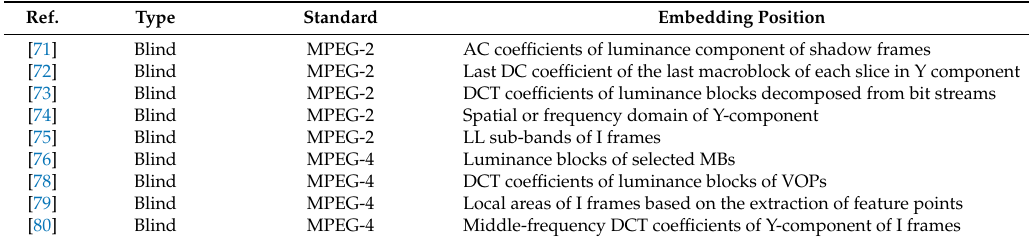
Table 9. Summary comparison of several watermarking algorithms based on